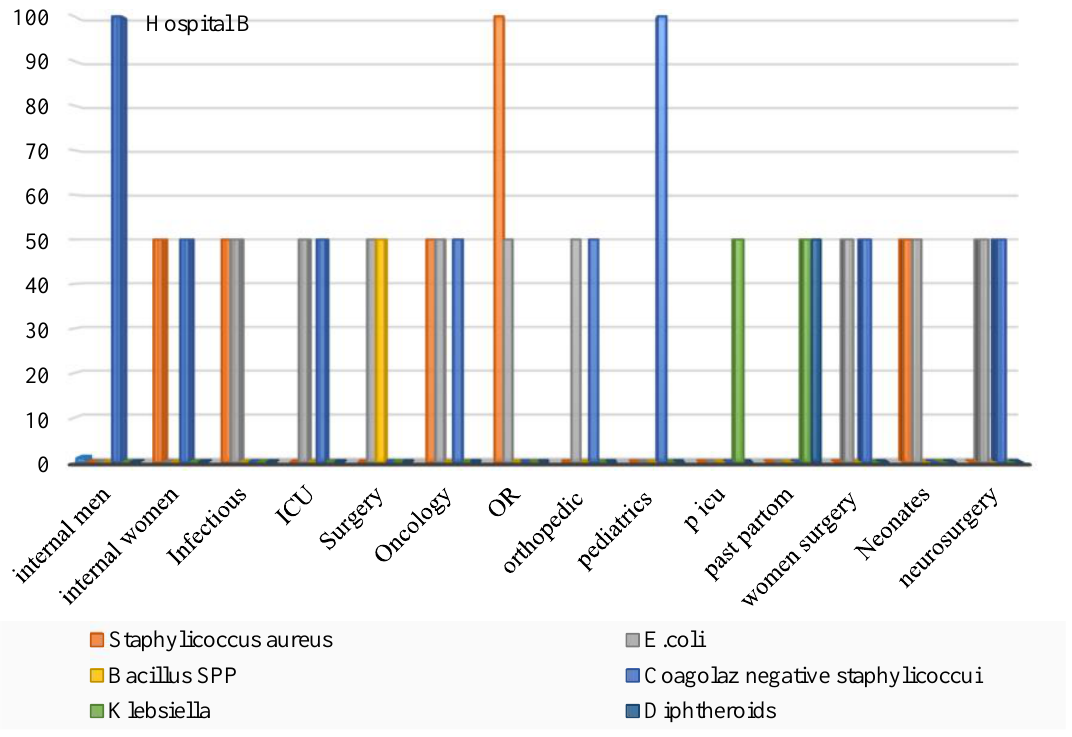
Fig. 6. Bacterial species frequency in different wards of hospital B After